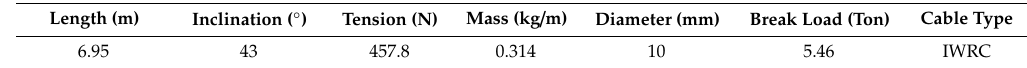
Figure 4. Laboratory setup for monitoring serviceability. Table 1. Properties of laboratory-scale cable .